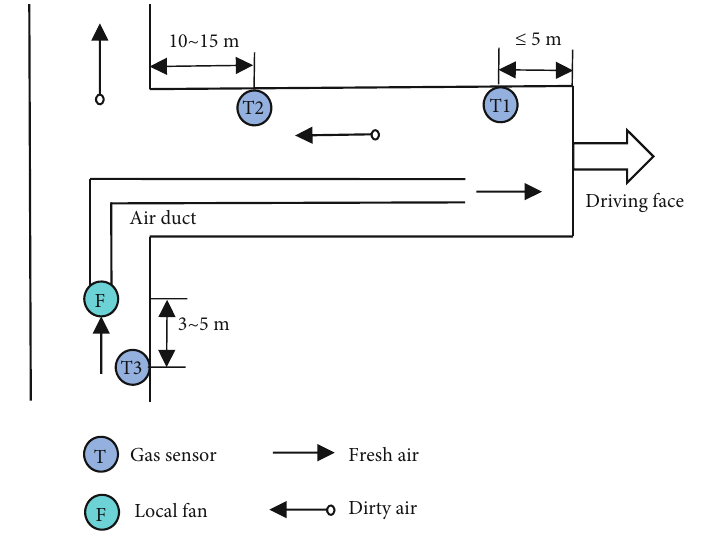
Figure 8: Prediction model of outburst risk based on CNN.